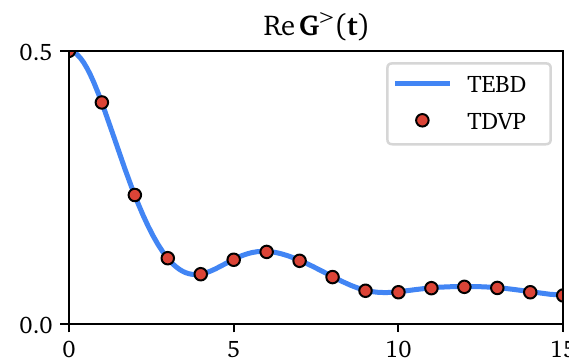
Figure 10: Comparison of the impurity greater Greens function G > ( t ) for a two orbital model between the TEBD time-evolution approach used in Ref. [ 18 ] and TDVP. The calculation was performed for a spin- and orbital degenerate model us- ing 9 bath sites per orbital and spin with parameters ε [ k ] = 0.1 ∀ k , l . Therefore, only diagonal entries of the Green’s function and V l are non-zero and for the diagonals there is only one independent function, i.e., ( t ) = δ G > G > ( t ) . Interaction parameters were U = 1, J = 0.1. The impurity l (cid:48) l l (cid:48) , l on-site energy was chosen to obtain particle hole symmetry, i.e., ε The time step for TEBD was ∆ t = 0.01 and for TDVP ∆ t = 0.1, since TDVP generally allows to use larger time steps [ 50 ] . Truncated weight (sum of all truncated Schmidt values) for TEBD was 10 − 12 without restricting the bond dimension, and for TDVP it was 10 − 9 for all links except the impurity-impurity links which were not truncated, but restricted to a maximal dimension of